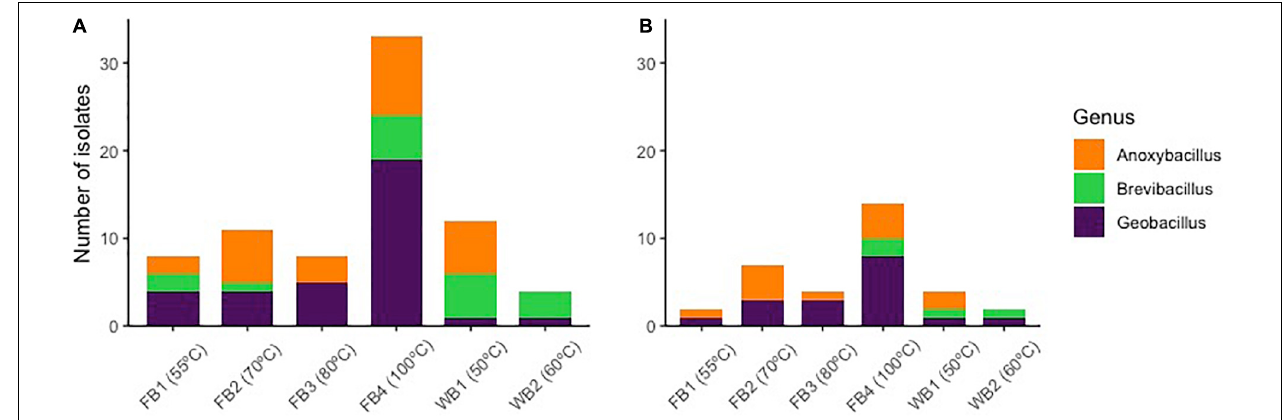
FIGURE 3 | Relative abundances of the taxonomic groups assigned to the isolates grown at 55 ◦ C, at the maximum classification level, capable of degrading oil (A) and producing biosurfactants (B) . Environmental temperatures of each sample are shown. Sequences were assigned with 97% similarity against the SILVA database v.